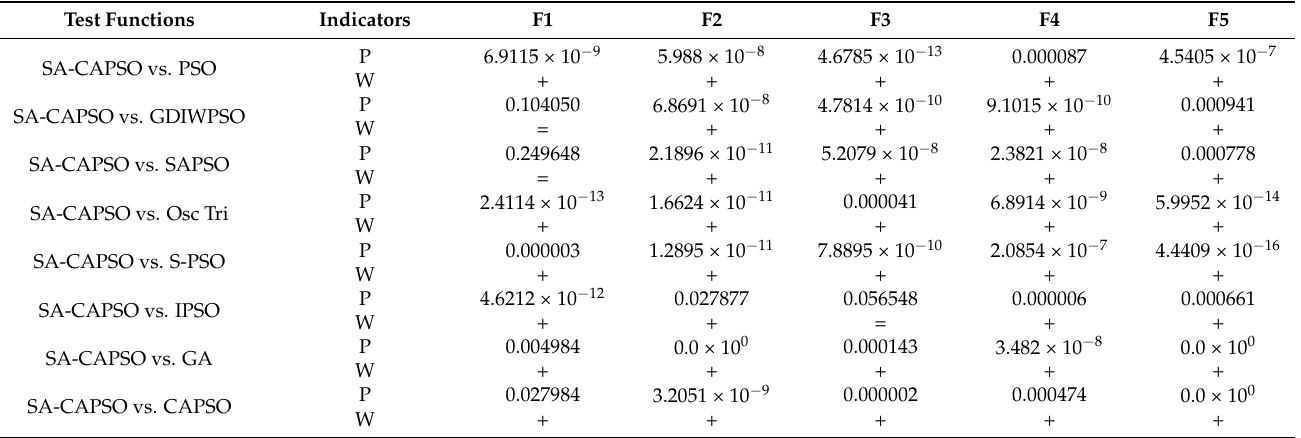
Table 13. Wilcoxon Rank Sum Test